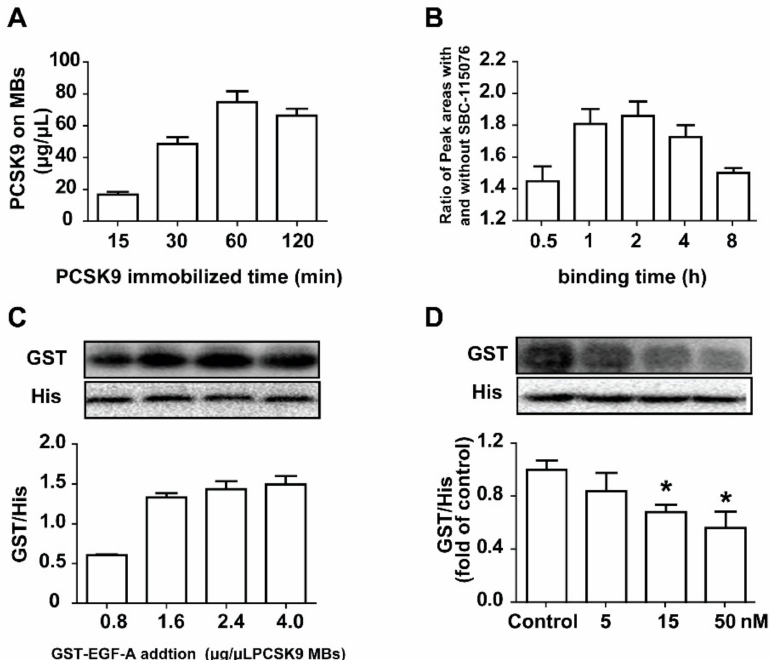
Figure 3. Establishment of the method for evaluating the PCSK9/LDLR interaction. The effects of the immobilized time of the PCSK9-MBs ( A ); the binding time between the ligands and the PCSK9-MBs ( B ) and the amounts of GST-EGF-A ( C ) on the binding assay were investigated; ( D ) The method established was verified by mixing GST-EGF-A (2.4 µ g/ µ L PCSK9-MBs) and the PCSK9-MBs in presence of positive compound SBC-115076 with different concentrations (5, 15, and 50 nM), and the GST/His ratios were monitored by western blot. The control group was conducted without the addition of SBC-115076. The values are the mean ± SEM deviation of the three independent experiments. * p < 0.05; ** p < 0.01, compared with the control